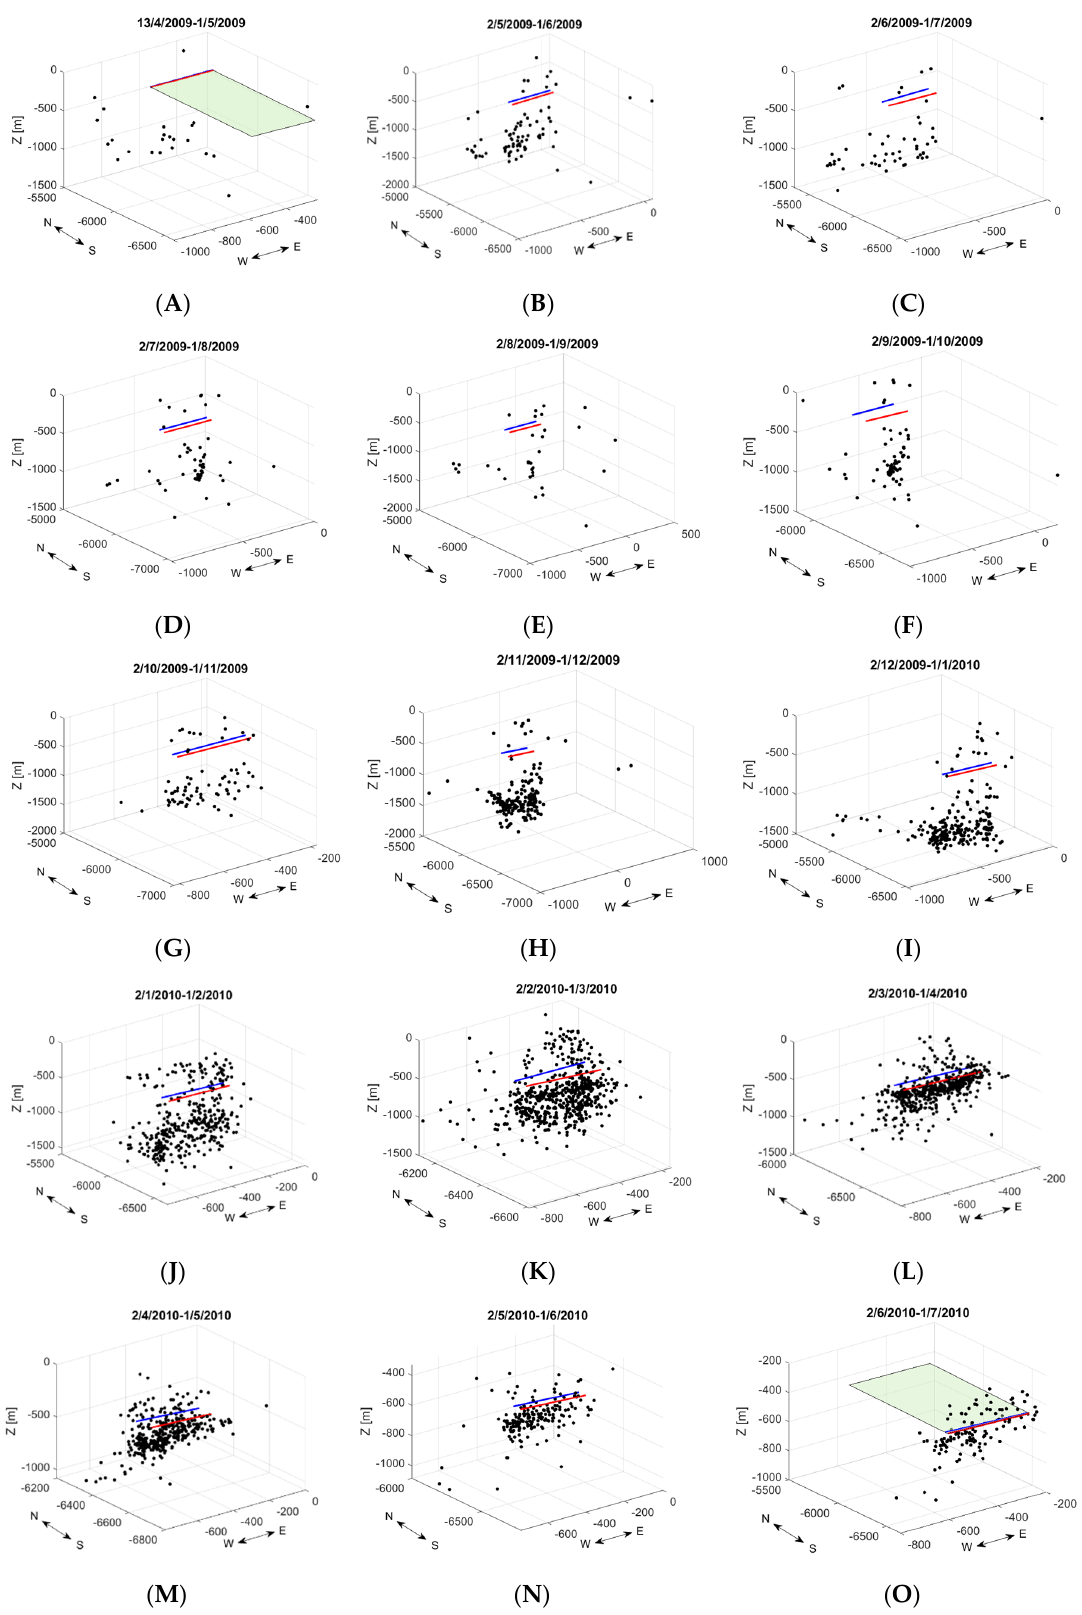
Figure 6. ( A – O ) Location of the point cloud in monthly intervals along with the current position of the coalface at the beginning and end of the interval. The green rectangle shows the whole area of mining work.